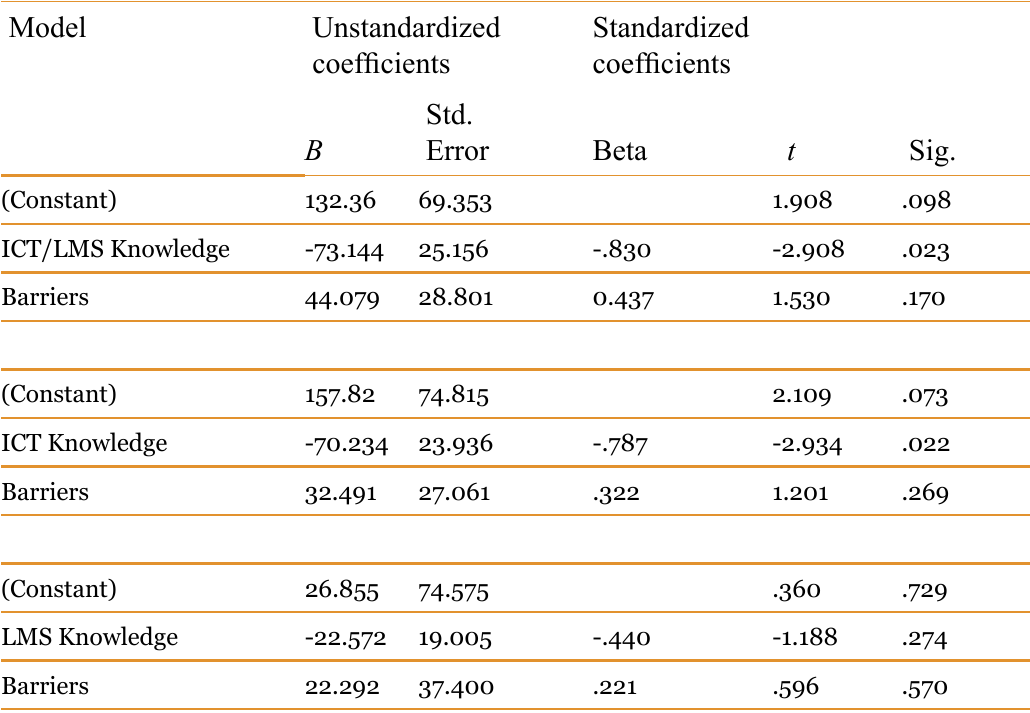
Regression Using Barriers and LMS and ICT Dimensions Separately in Two Regression